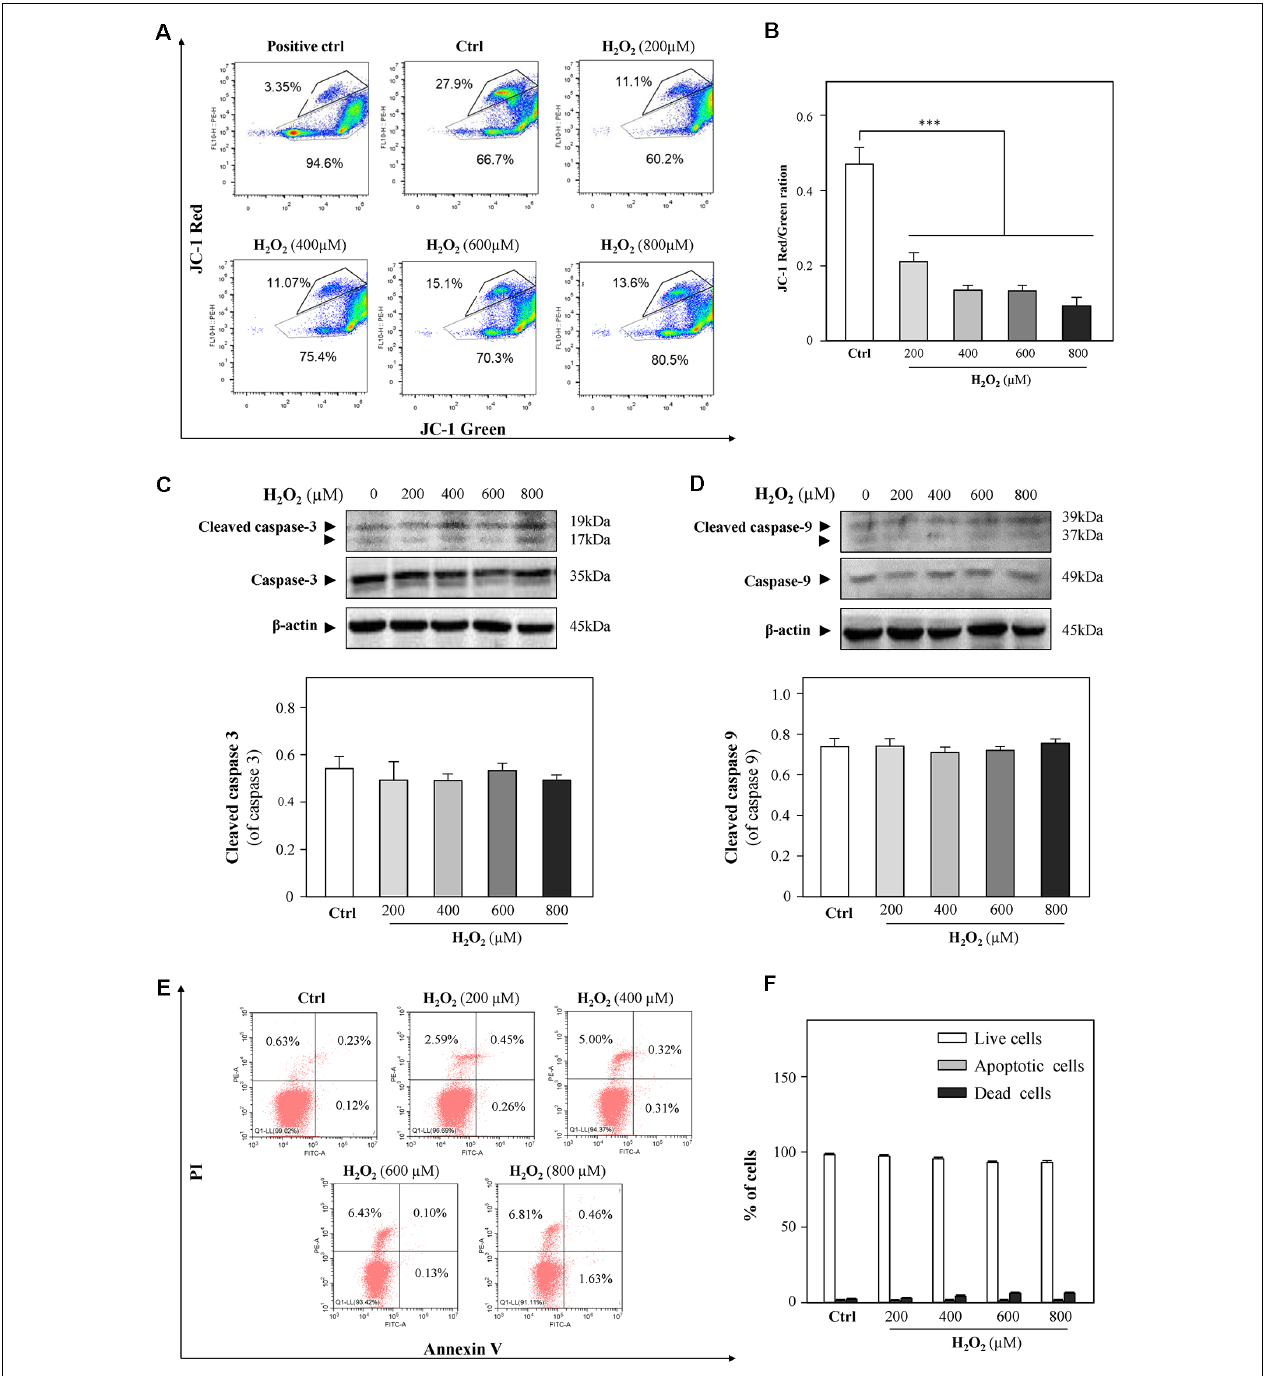
FIGURE 2 | H 2 O 2 shows impairment functions to mitochondria, but it cannot induce apoptosis in HT-22 cells. Cultured HT-22 cells were incubated with H 2 O 2 at different concentrations (200–800 µ M) for 24 h; control group (Ctrl) consists of the untreated cells. (A) Representative dot plot of the changed mitochondrial membrane potential using flow cytometry after labeling the fluorescent probe with JC-1. The changes in mitochondrial membrane potential induced by 10 µ M CCCP were used as positive control. (B) Ratios of JC-1 red/green were shown in histograms. (C) Western blot analyses of cleaved-caspase 3 and caspase 3. Expression of β -actin was served as a loading control. Quantification plot of cleaved-caspase 3 was shown in histograms. (D) Western blot analyses of cleaved-caspase 9 at and caspase 9. Expression of β -actin served as a loading control. Quantification plot of cleaved-caspase 9 was shown in histograms. (E) Cell apoptosis was detected by flow cytometry with Annexin V/PI apoptosis detection kit using a flow cytometer. (F) Values are in percentage of apoptotic cell rates of live cells, apoptotic cells, and dead cells, as calibrated from (E) . Values are in percentage as compared to control (no drug treatment), and each point represents the mean ± SEM, n = 3. ∗∗∗ p < 0.001 vs. control group. CCCP, carbonyl cyanide m-chlorophenylhydrazone.